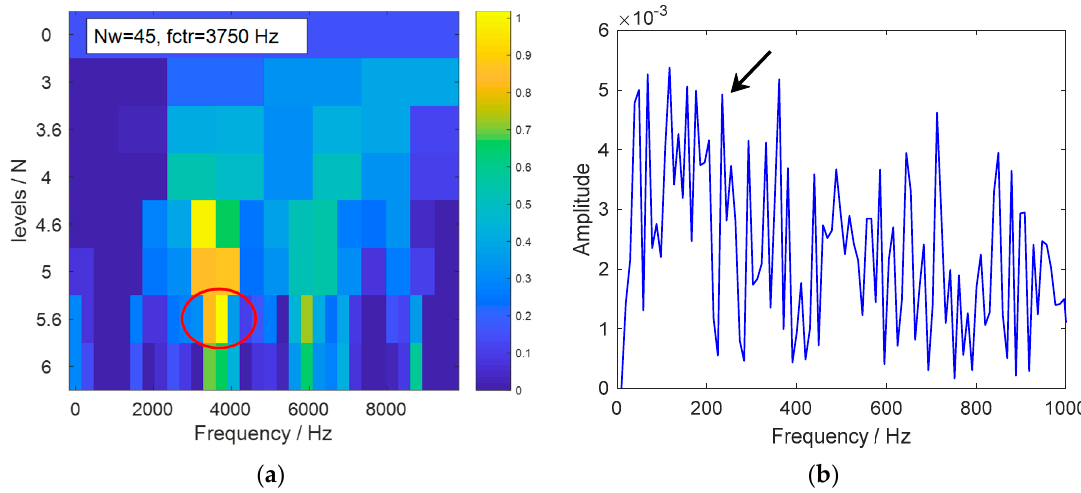
Figure 11. Results based on maximum spectrum (MSK): ( a ) Kurtogram of the signal; ( b ) envelope spectrum of the filtered signal.